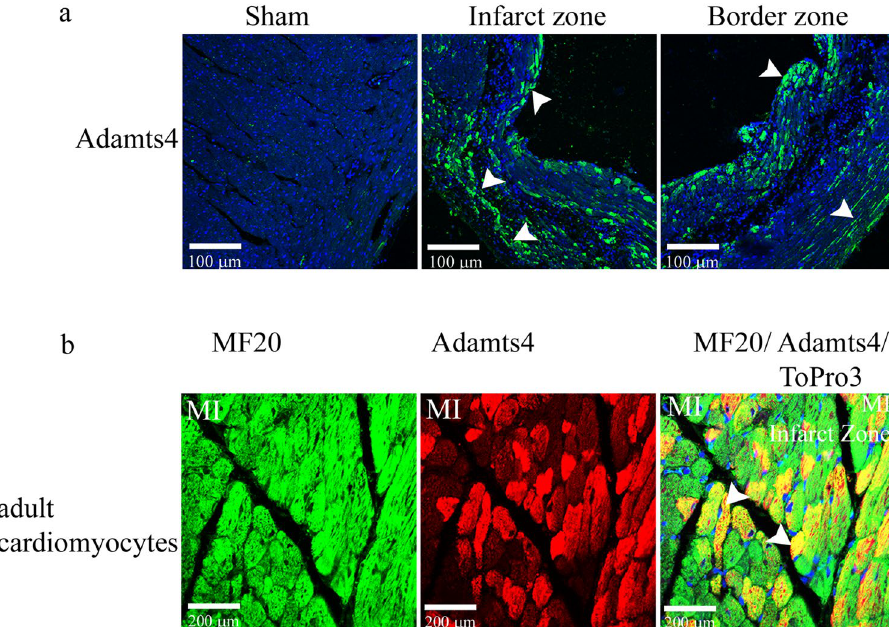
Figure 2. Adamts4 protein is reactivated in adult murine heart following 4 weeks post-MI. Panel a. shows IHC with anti-Adamts4 antibody (shown in green colour) and Topro3, used as nuclear stain (shown in blue). 4 weeks post-MI, induced reactivation of murine Adamts4, as indicated by the arrowheads in the infarct and border zones of adult murine chamber myocardium in comparison to sham operated mice. Moreover, this injury induced expression of Adamts4 is expressed in cardiomyocytes as shown in panel b where IHC with anti-Adamts4 (shown in red colour) and cardiomyocyte specific anti-MF20 (shown in green colour) antibodies following 4 weeks post MI in adult murine show colocalized expression, the colocalization is pointed out by the arrowheads in the MF20/Adamts4/Topro3 merged image. n =